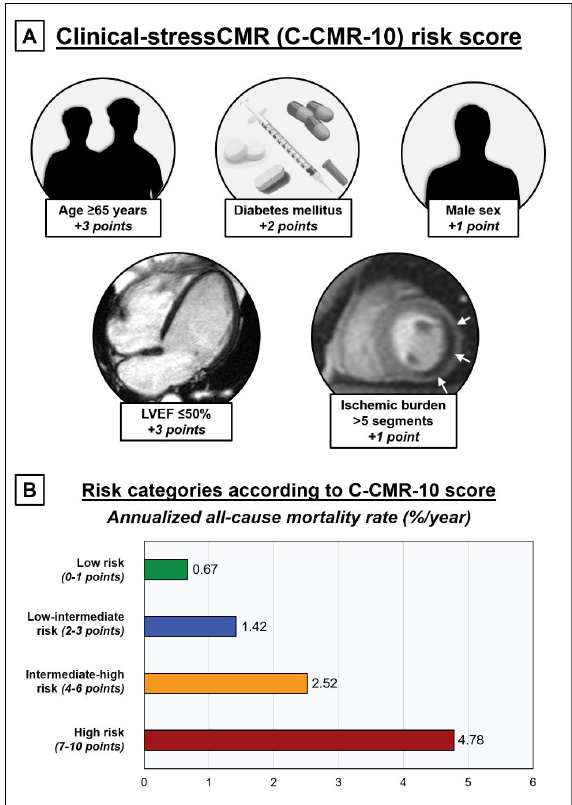
Figure 1. Clinical-stressCMR (C-CMR-10) score to predict all-cause mortality. ( A ) Clinical and stressCMR variables and thresholds to calculate the C-CMR-10 score. ( B ) Annualized all-cause mortality stratification according to the C-CMR-10 score risk categories. Abbreviations: LVEF = Left ventricular ejection fraction; stressCMR = Vasodilator stress cardiac magnetic